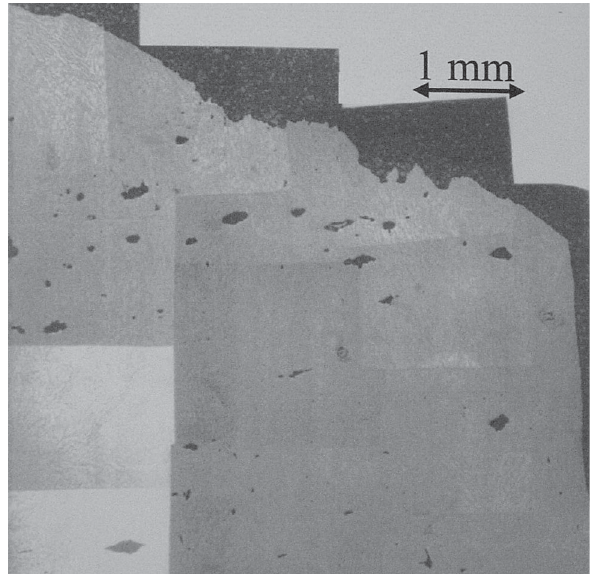
Figure1. metallographic cut of a F32 steel aged 3000 h at 325 ºC and strained to fracture.